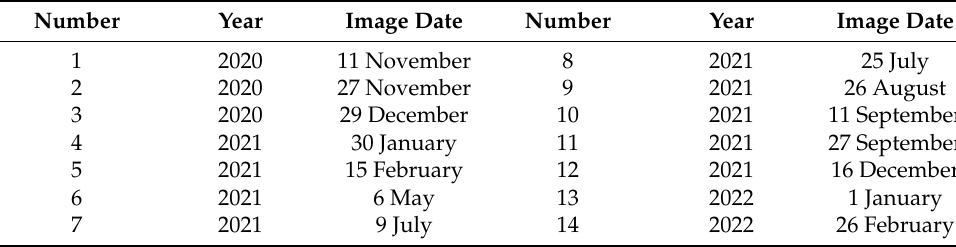
Table 1. Dates of selected Landsat 8-9 images.